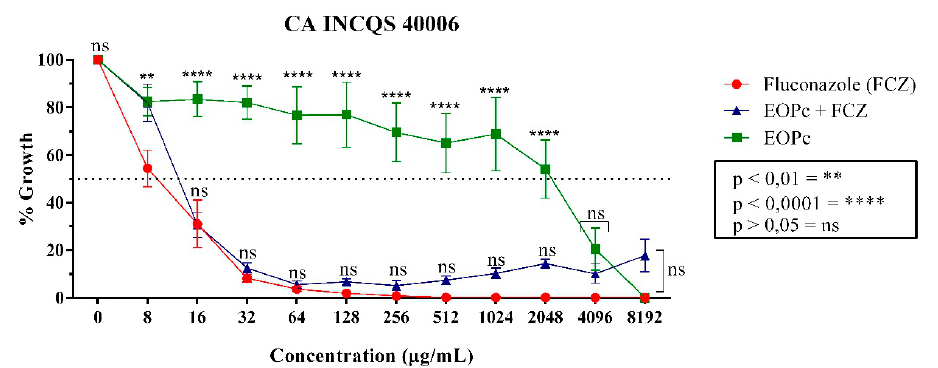
Figure 1. Anti- Candida potential of essential oil of Piper caldense (EOPc) against strains of Candida albicans 40006 INCQS.